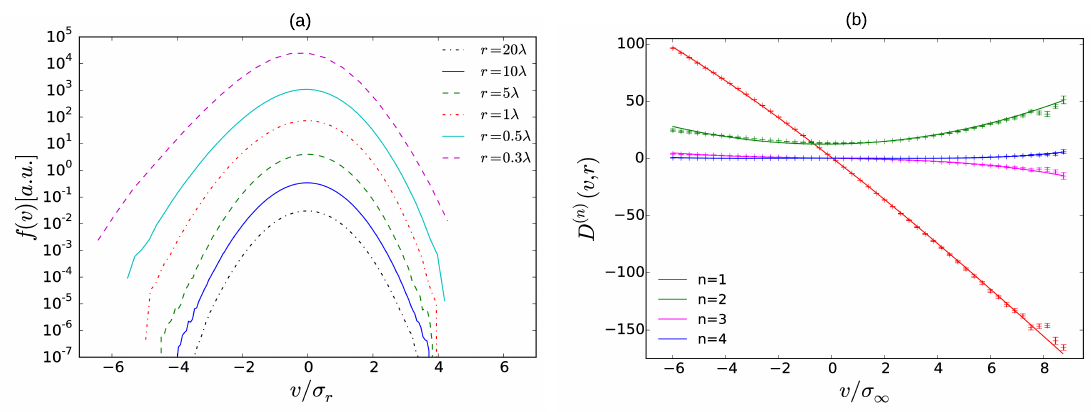
Figure 25. ( a ) evolution of the velocity increment PDF in scale for the intermediate case α = 0.15. The PDFs show a slight asymmetry at small scales. ( b ) estimation of the Kramers–Moyal coefficients from DNS of the intermediate case α = 0.15. The fits correspond to polynomials of the order n of the coefficient except for n = 1 where a polynomial of order three has been used. The reduced Kramers–Moyal coefficients have been determined according to K 1 = 0.4356 ±